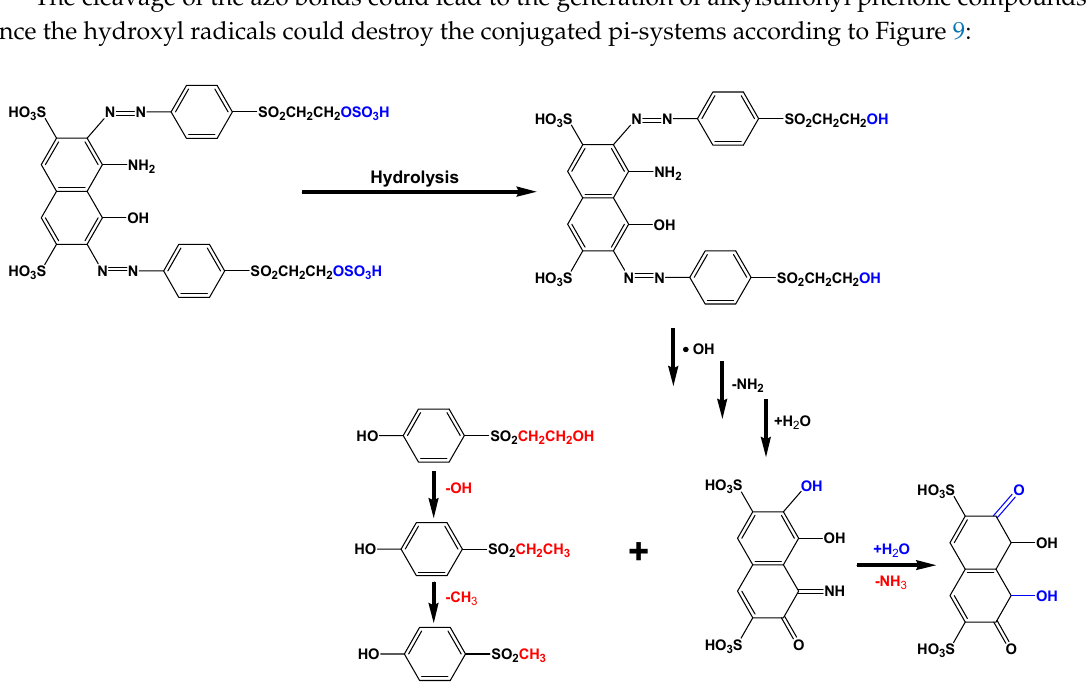
Figure 9. Possible mechanism of azo ‐ bond cleavage in dye molecules.